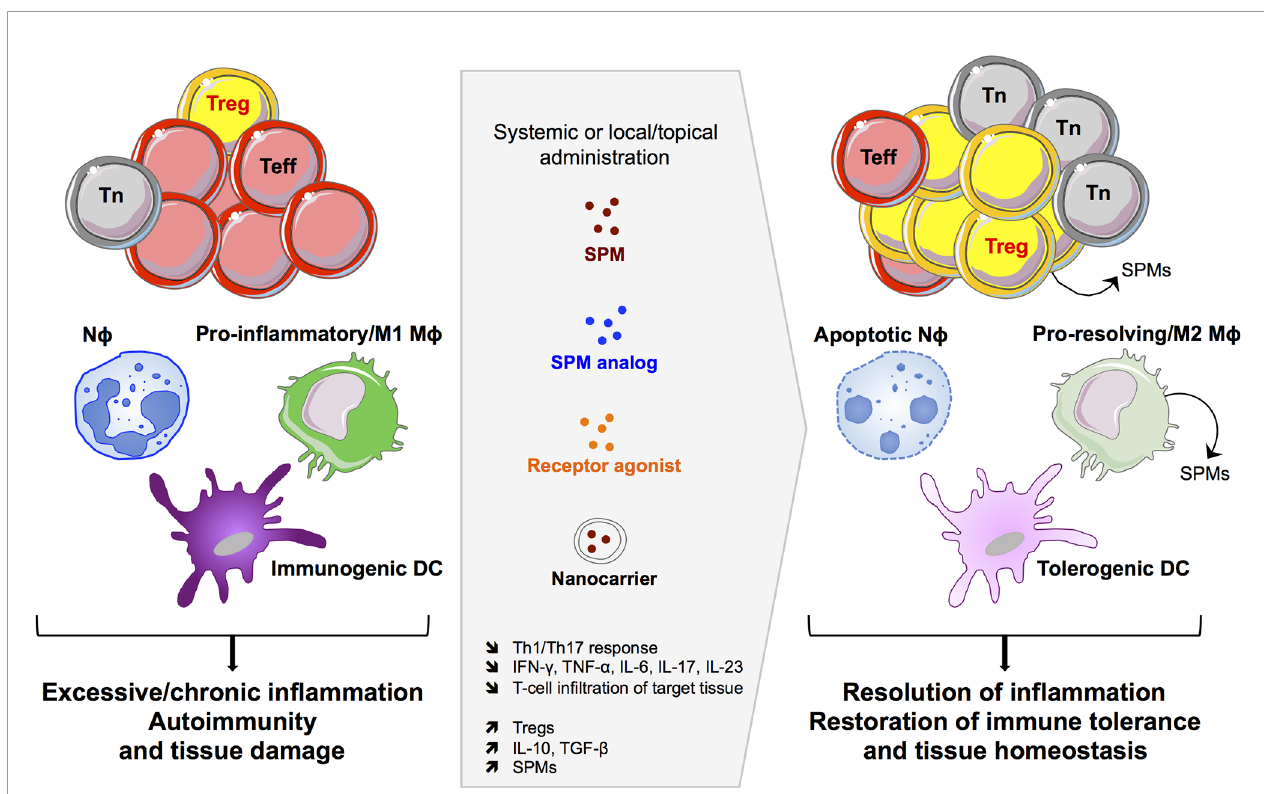
FIGURE 3 | SPM-based therapeutic opportunities. Targeting the SPM pathway can impact innate and adaptive immune cells to induce ef fi cient resolution of excessive in fl ammatory responses and to restore immune tolerance and tissue homeostasis. N f , neutrophil; M f , macrophage; DC, dendritic cell; Teff, effector T cell; Tn, naïve T cell; Treg, regulatory T